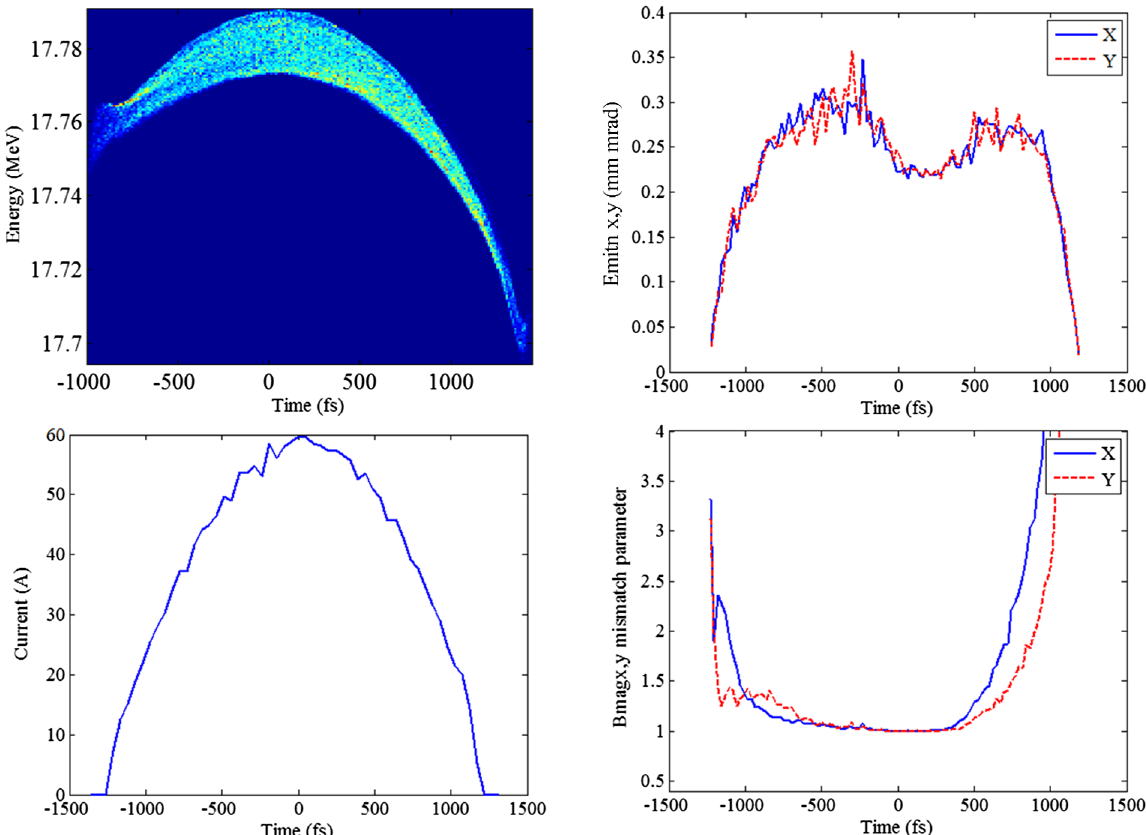
FIG. 11. Plots of transverse and longitudinal electron beam parameters at IP vs time relative to the bunch center. The upper left shows time-energy phase space with mean energy of 17.9 MeVand rms bunch length of 580 fs, a factor of 2 longer than at gun exit due to space charge dynamics. The upper right shows that slice emittance remains low. The lower left shows 60 A peak current. The lower right plot shows B , which measures how well the different time slices overlap the central time slice in transverse phase space. Ideally B mag for all slices, but the central high current slices are most